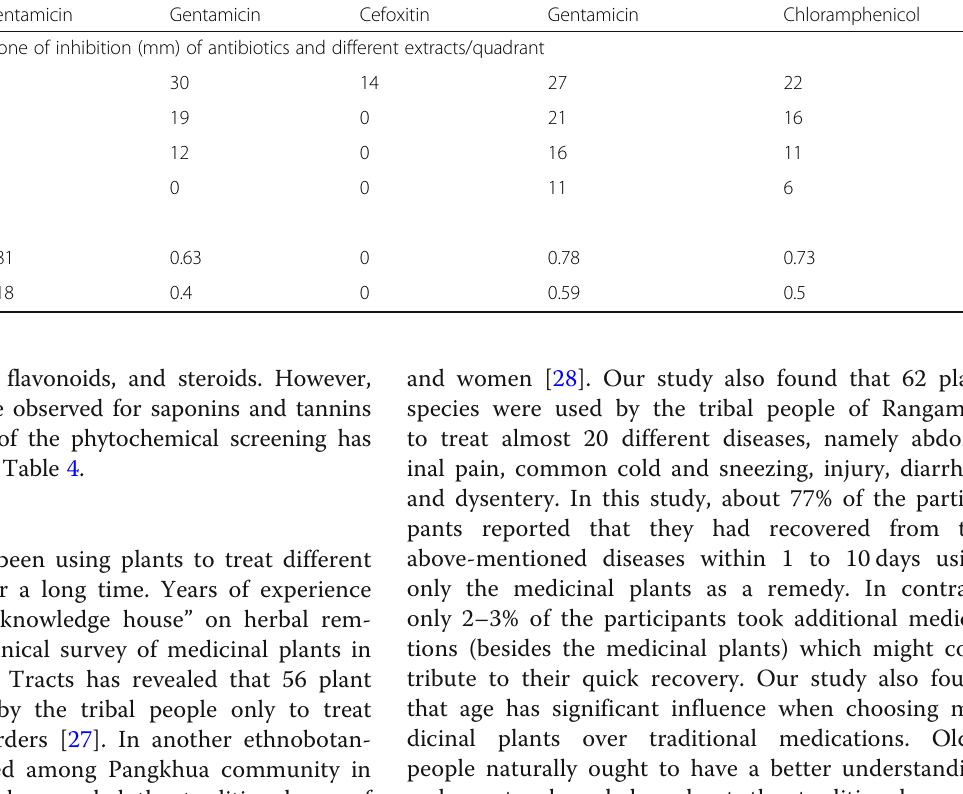
Table 3 Antibacterial test results of the ethanolic, methanolic, and aqueous extracts of Heptapleurum hypoleucum. Ethanolic extract showed the highest zone of inhibition against Staphylococcus aureus (21 mm) Extract (quadrant) The average diameter of zone of inhibition (mm) of antibiotics and different extracts/quadrant